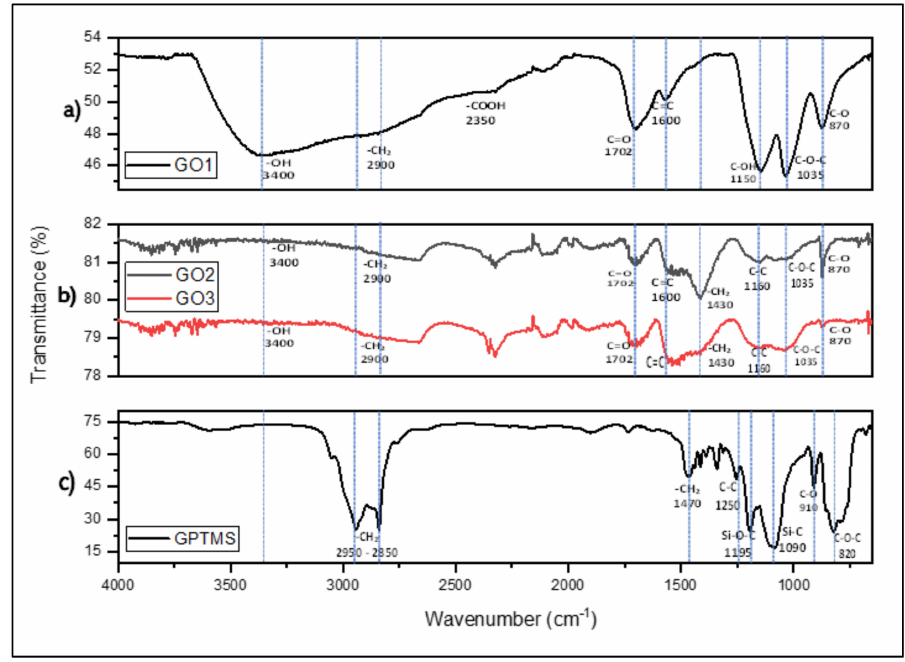
Figure 3. FTIR-ATR spectra of ( a ) GO1, ( b ) GO2, GO3, and ( c )